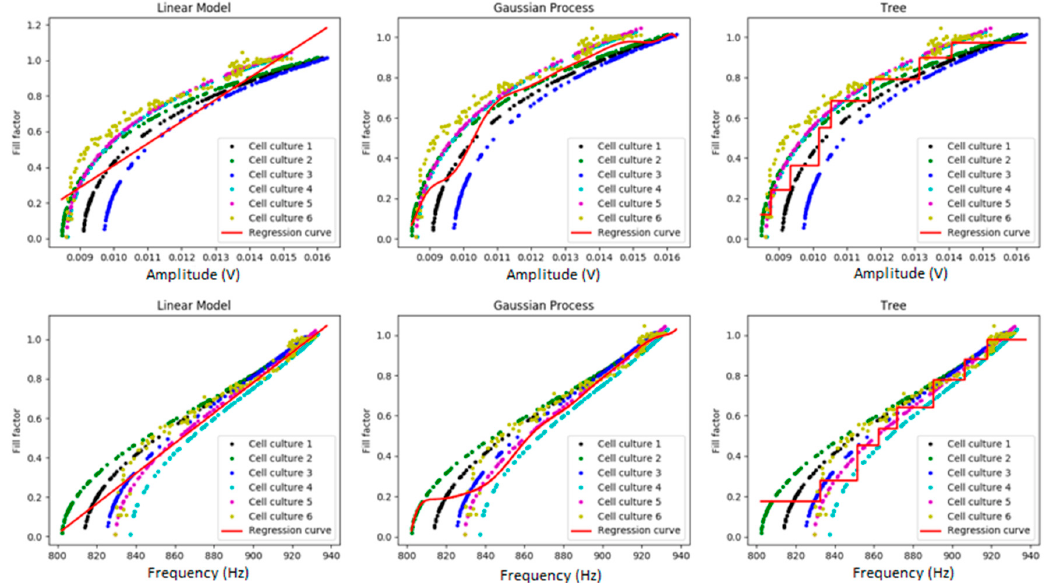
Figure 5. Linear regression, RTs, and GPs of fill-factor against amplitude (volts) and frequency (Hz) for myoblasts. We can observe the model implemented for myoblasts (red line) and the data obtained from the six different myoblast cell cultures.